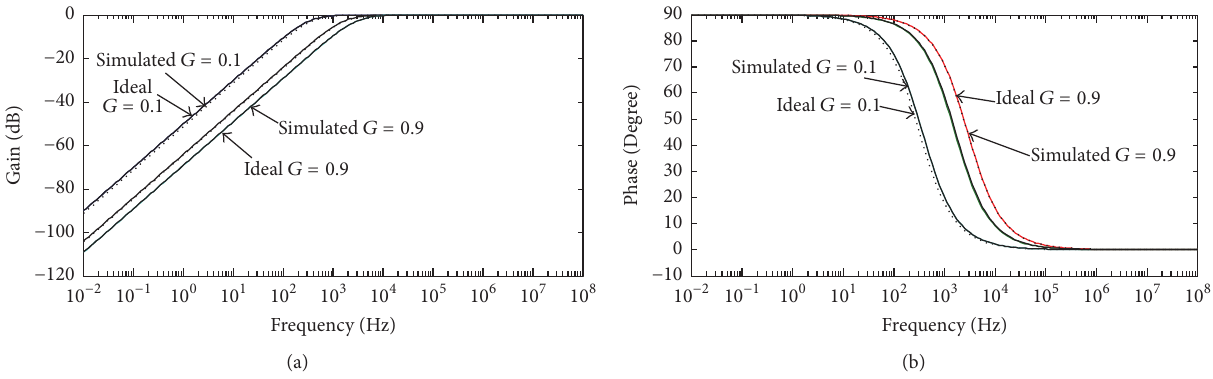
Figure 9: Frequency response for high pass filter: (a) gain and (b) phase